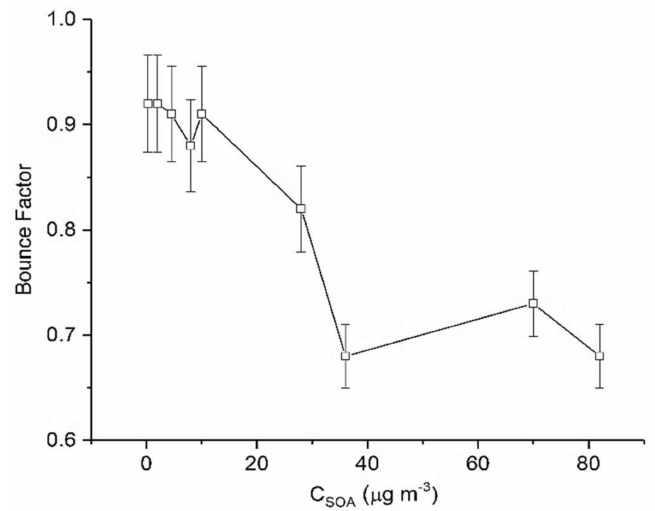
Figure 2. Calculated maximum BF for α -pinene derived SOA as a function of C SOA . Error bars represent 1 standard